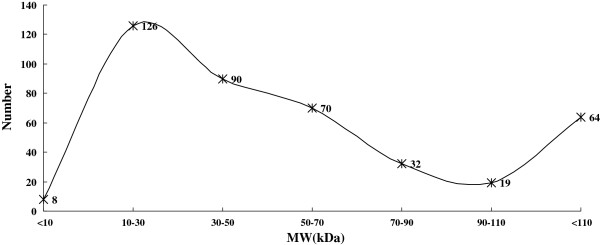
Distribution of PI about the potential biomarkers. Turning curve shows the global skewness distribution of the data. The data that PI ≤ 8 (Skewness = 0.330 SE = 0.146; Kurtosis = 0.425, SE = 0.292, P<0.05) and 8<PI ≤ 10 (Skewness = 0.211, SE = 0.240; Kurtosis = 0.198, SE = 0.476, P<0.05) also showed skewed distribution though looks like normal distribution.